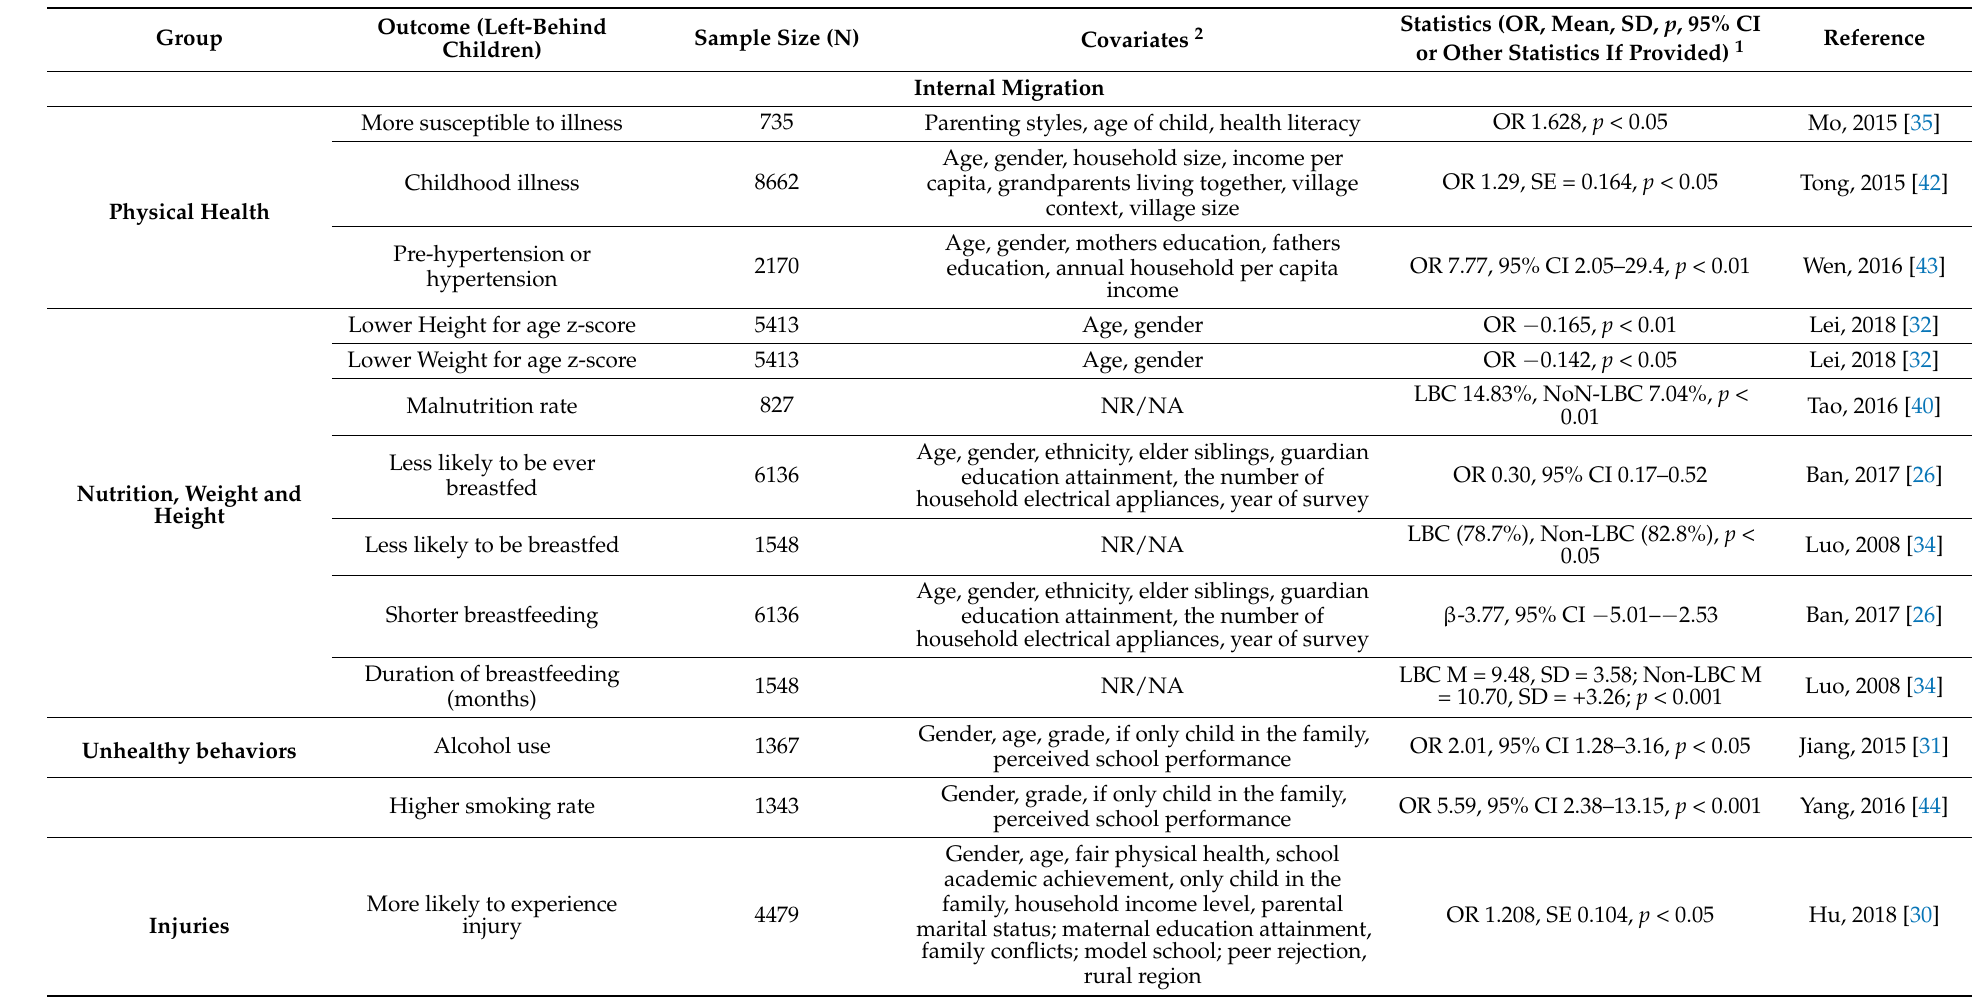
Table 2. Main outcomes (only statistically significant outcomes